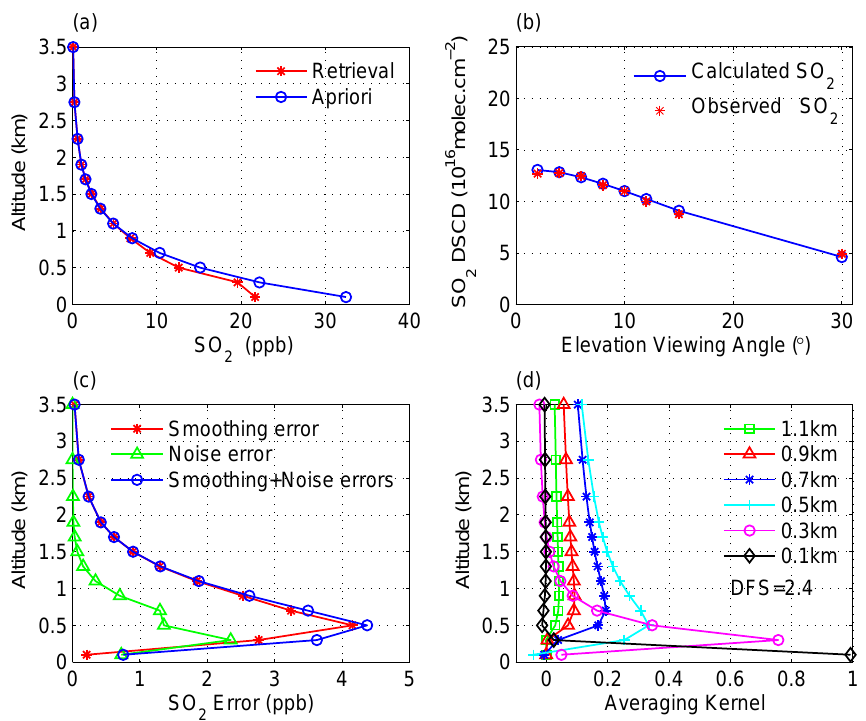
Figure 5. Example of SO 2 vertical profile retrieval from MAX-DOAS measurements at Xianghe (29 September, 2010 at 10:15LT). (a) A priori (blue) and retrieved profile (red); (b) observed (red) and calculated (blue) DSCD (c) smoothing error (red), noise error (green) and sum of these two (blue); (d) averaging kernels.